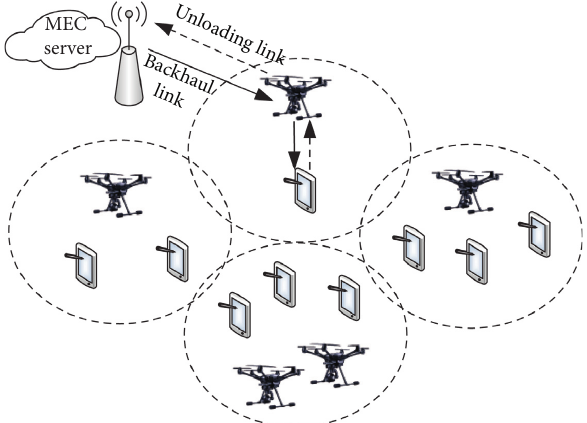
Figure 1: System model of collaborate task offloading of the UAV